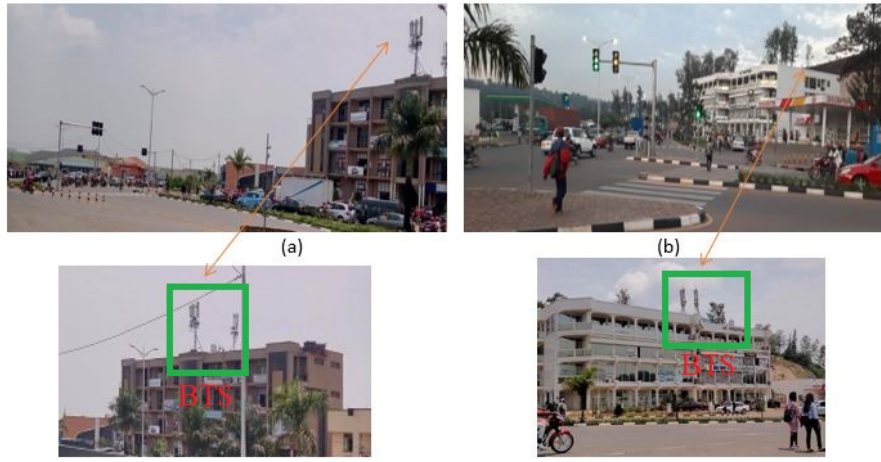
Figure 7. Position of BTS at the junctions ID001 and ID003. ( a ) the BTS positioned at 50 m from intersection ID001 and ( b ) the BTS positioned at 30 m from intersection